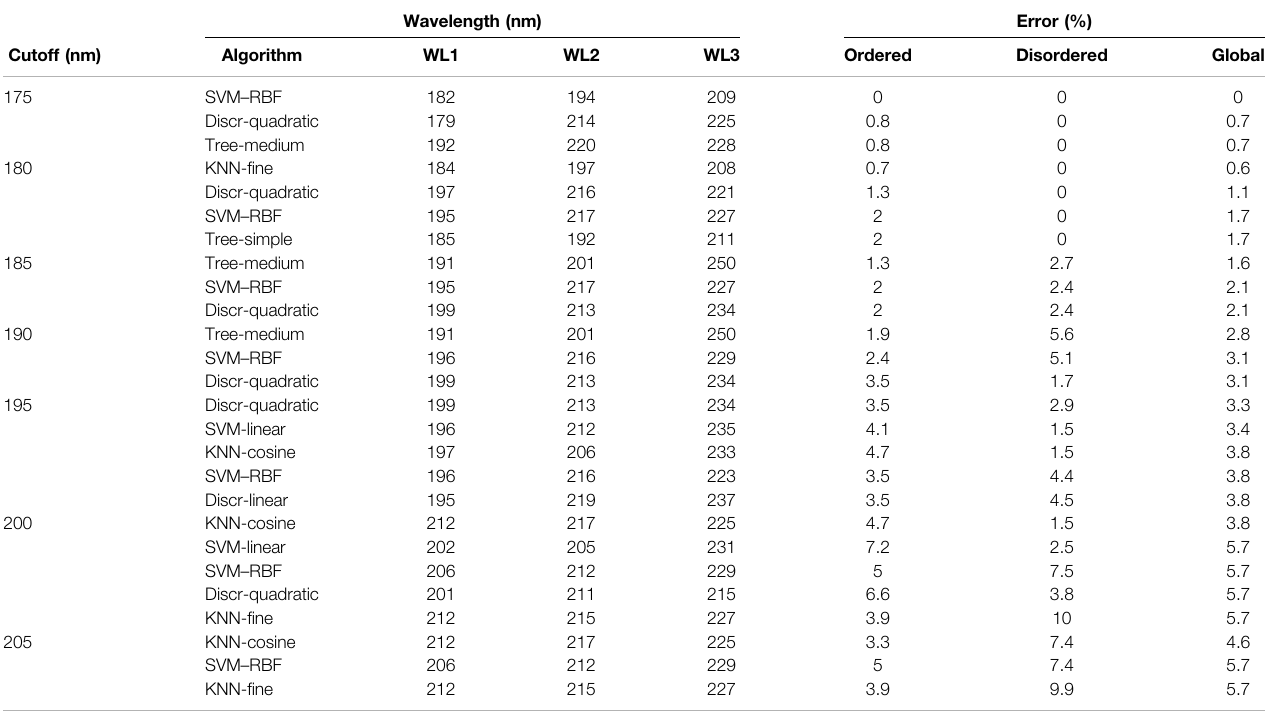
TABLE 1 | Disorder – order classi fi cation using three wavelengths.